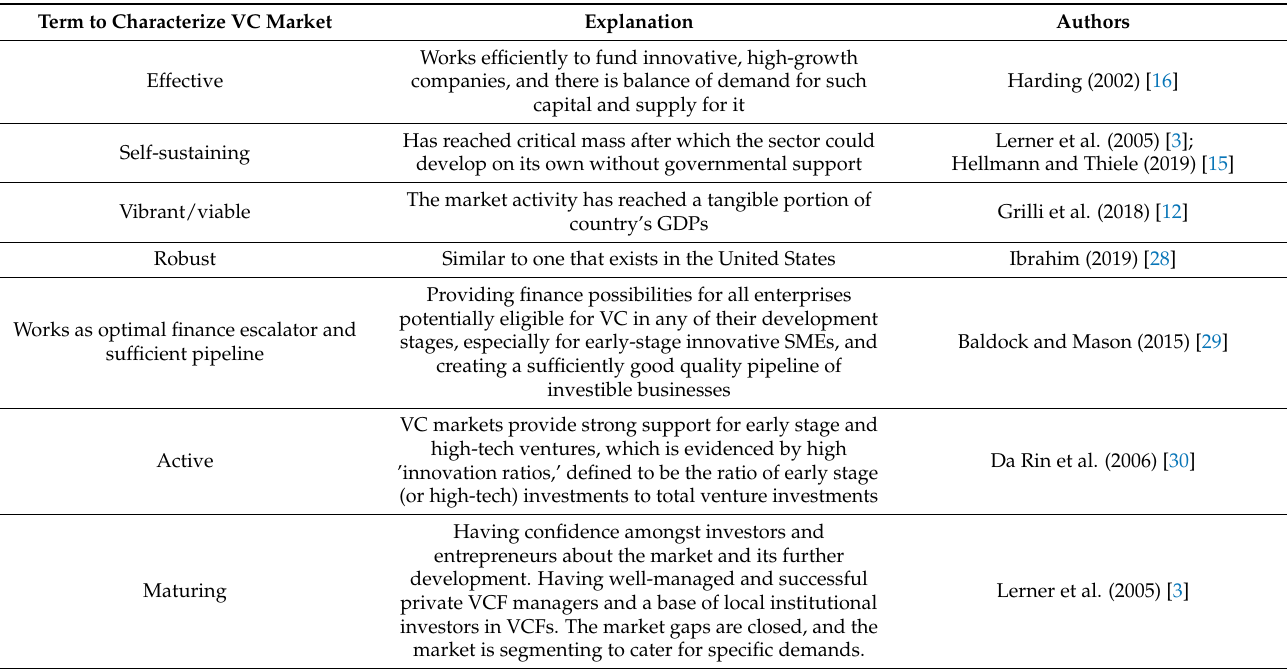
Table 1. Terms used to describe VC market desirable